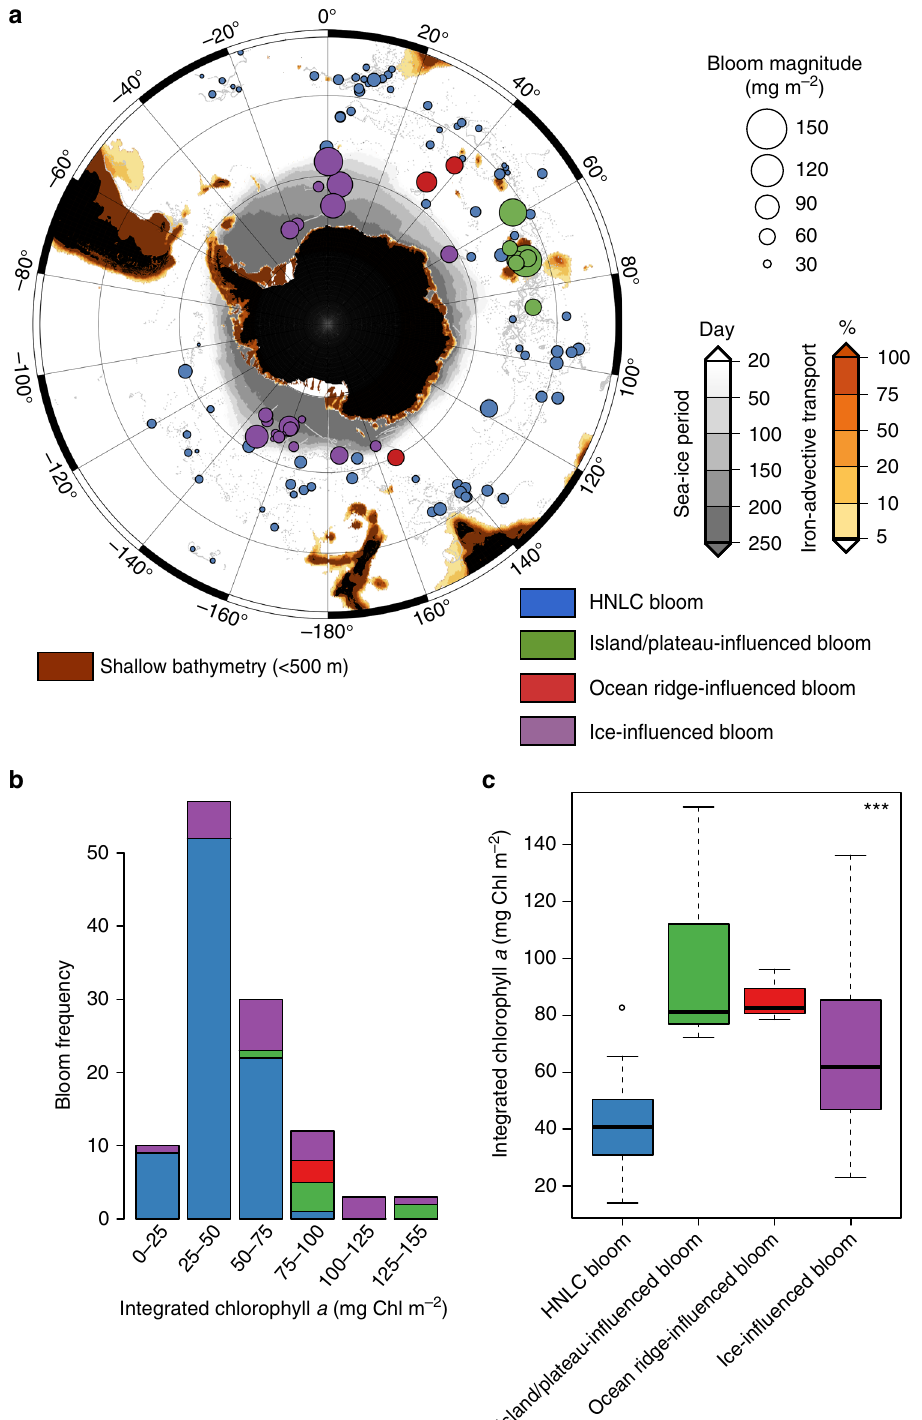
Fig. 1 Phytoplankton bloom distribution, type and biomass in the Southern Ocean. Map ( a ) of the different bloom types (i.e., blue circles: HNLC; green circle: island/plateau-in fl uenced; red circle: ocean ridge-in fl uenced; purple circle: ice-in fl uenced) sampled. The magnitude of the bloom (i.e., the maximum depth-integrated biomass) is related to the size of the colored circles. The gray dots indicate the individual fl oat pro fi les. The red, orange, and gray zones are, respectively, shallow areas (>500 m), areas with downstream iron delivery (%; percent of iron remaining in a water parcel after scavenging relative to its initial concentration in shallow areas based on the Lagrangian modeling of horizontal iron delivery), and areas characterized by a seasonal sea ice cover. Histograms ( b ) of the frequency of and boxplot ( c ) according to the bloom type are displayed in relation to the bloom magnitude. In c , the top and bottom limits of each box are the 25th and 75th percentiles, respectively. The lines extending above and below each box, i.e., whiskers, represent the full range of non-outlier observations for each variable beyond the quartile range. The results of the Kruskal – Wallis H test are shown in panel c and depict regions with statistically signi fi cant differences between the magnitudes of the bloom at the 95 % level ( p < 0.05). Asterisks (***) denote highly signi fi cant results ( p <